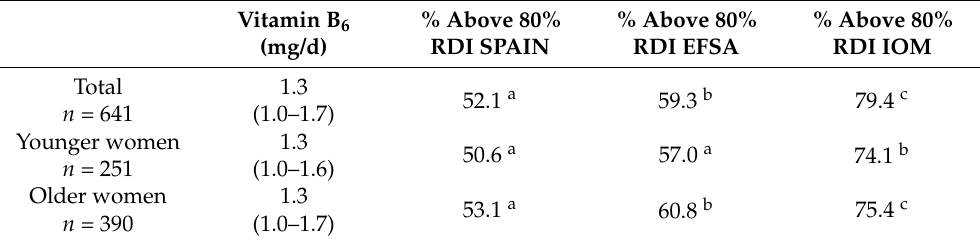
Table 5. Vitamin B 6 intake and prevalence of adequacy (percentage of population above 80% RDI) in women of childbearing age from the ANIBES study.